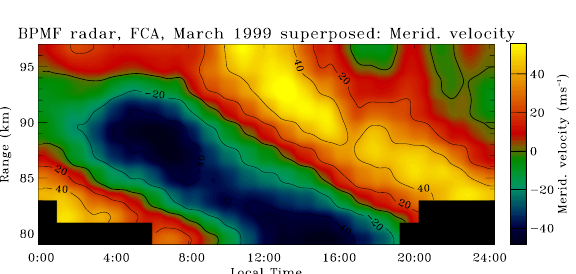
Figure7.Magnitude(top)andphase(bottom)ofthediurnalvariationoftheturbulent velocitydeducedbyharmonic(cid:12)tting.